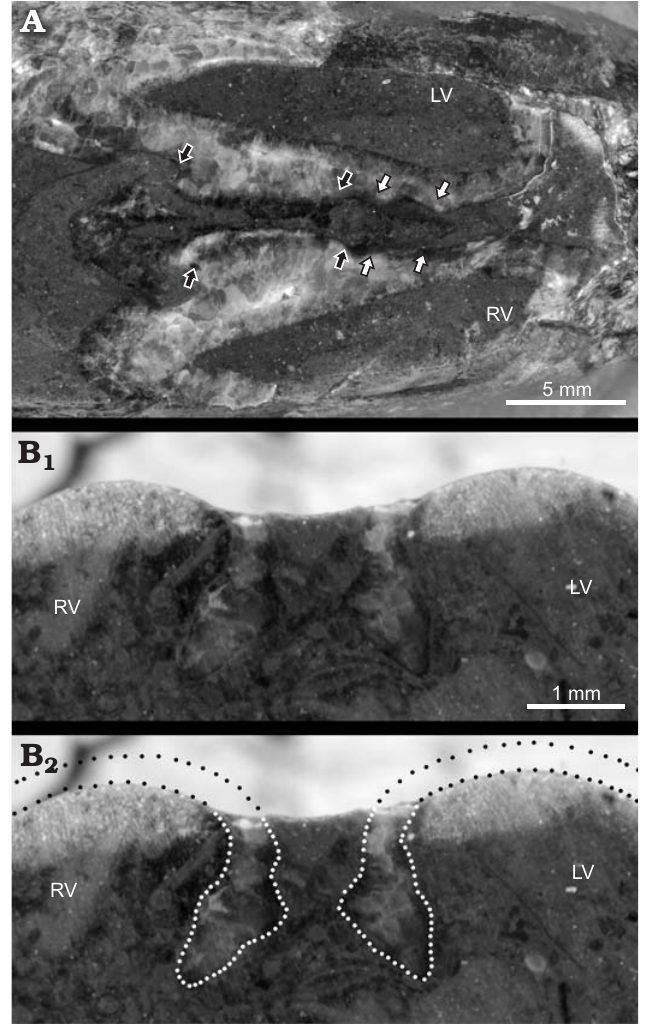
Fig. 9. The pholadomyoid bivalve Aksumya krystyni gen. et sp. nov. from the late Carnian, Late Triassic in southern Turkey; polished surfaces of cross sections showing hinge and nymph details. A . Mo184073 from Dumanl ı I; cross section cut horizontally through the umbones, showing hinge (white arrows) and ligament nymph (black arrows). B . Mo184074 from Terziler III, vertical cross section showing hinge area just below umbo, seen from the anterior; white dotted line in B 2 indicates the hinge area, black dotted line indicates the inferred shell material of the umbones. Abbreviations: LV, left valve; RV, right